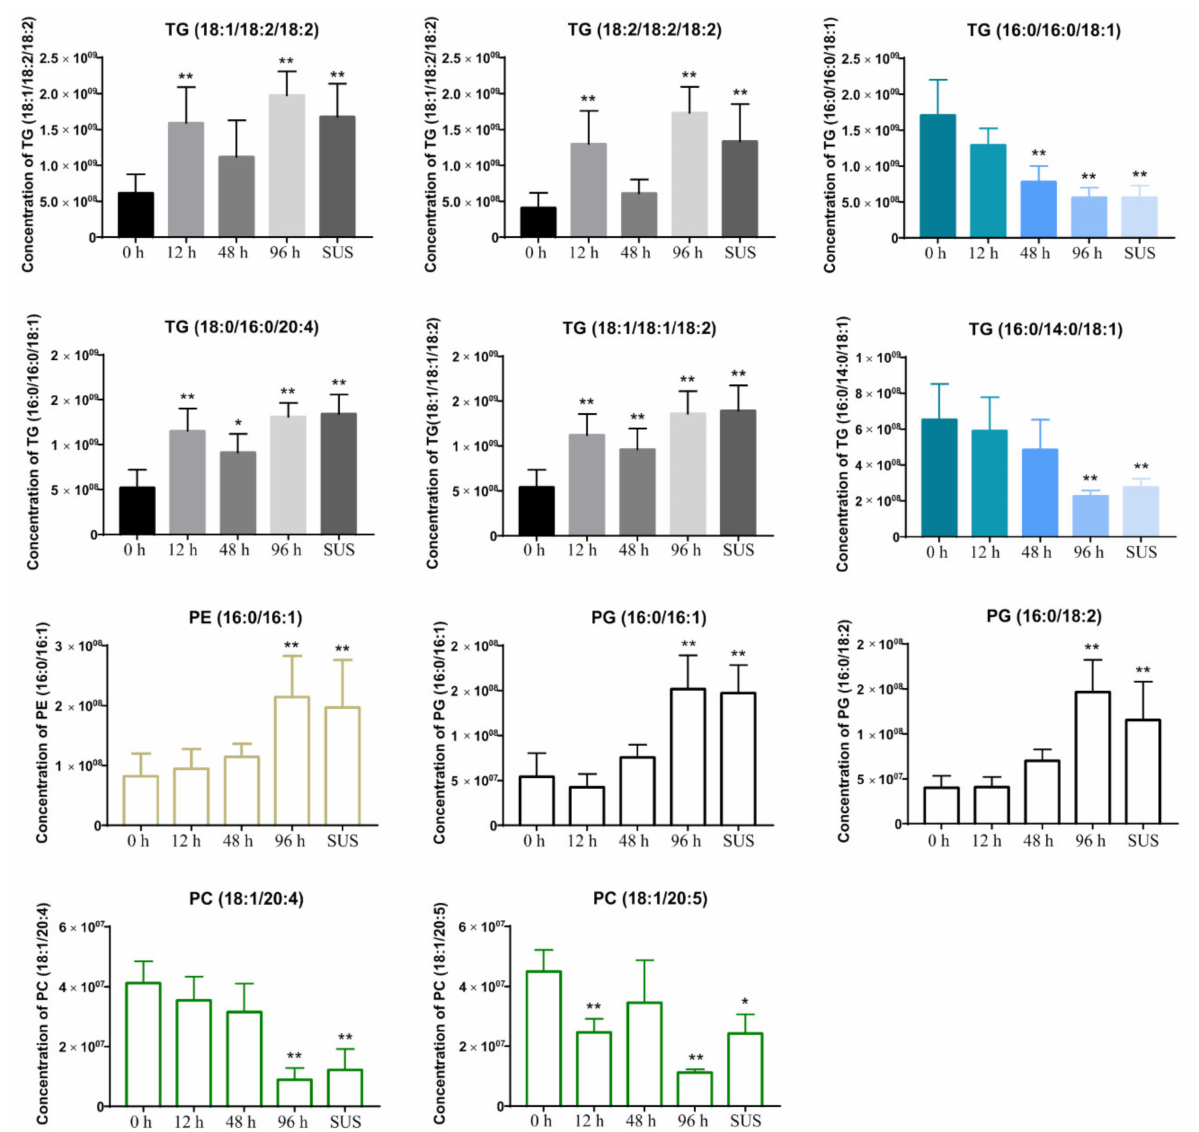
Figure 6. The major significant metabolites throughout the different times after the V. splendidus infection. Asterisks indicate significant differences: * p < 0.05 and ** p <